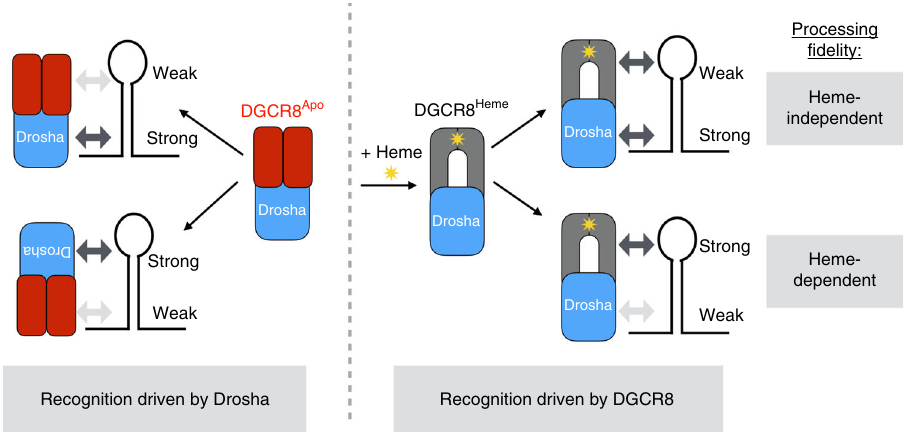
Fig. 6 Model for heme-dependent pri-miR recognition by Drosha and DGCR8. Each pri-miR contains two ssRNA/dsRNA junctions where one is a stronger Drosha-binding site (indicated by “ strong ” or “ weak ” ). Heme induces a conformational switch in DGCR8 that enables it to bind the terminal loop with higher speci fi city and af fi nity. Pri-miRs containing weak basal junctions are more heme dependent because placement of Drosha at the proper junction is driven by heme-bound DGCR8. For pri-miRs containing strong basal junctions, the interaction between the HBR and terminal loop can